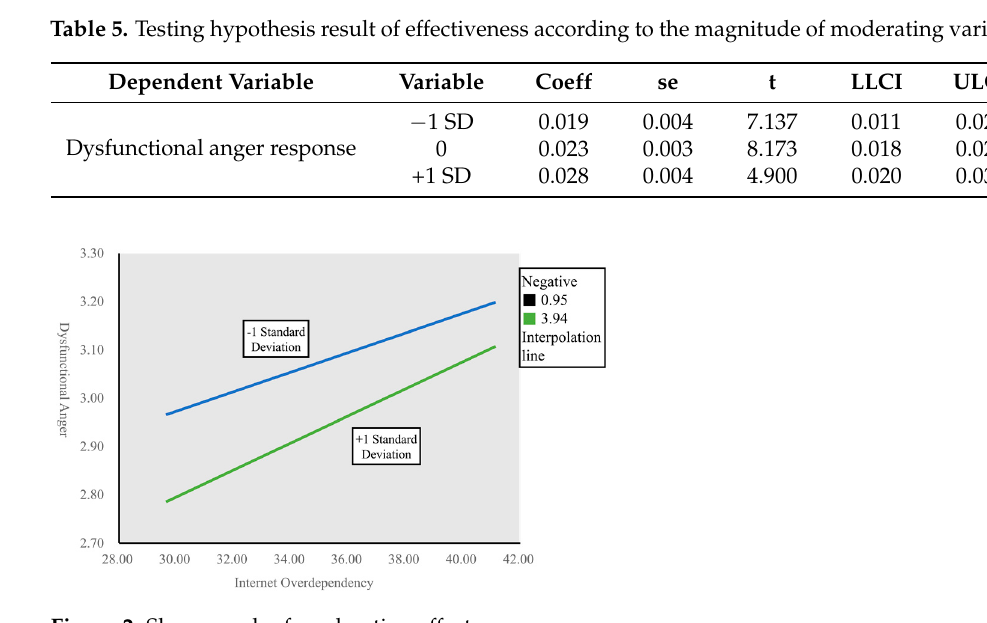
Figure 2. Slope graph of moderating effect.